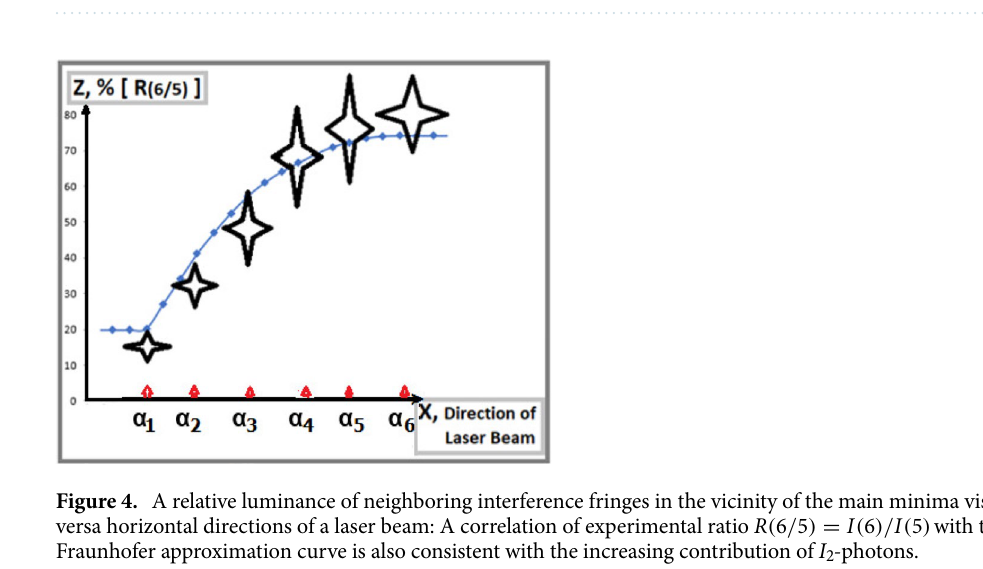
Figure 3. A relative luminance of fringes in x laser beam: A strong correlation of Experimental ratio R ( 7 / 6 ) curve is consistent with the increasing contribution of I 2 -photons while going against the decreasing I 1 .